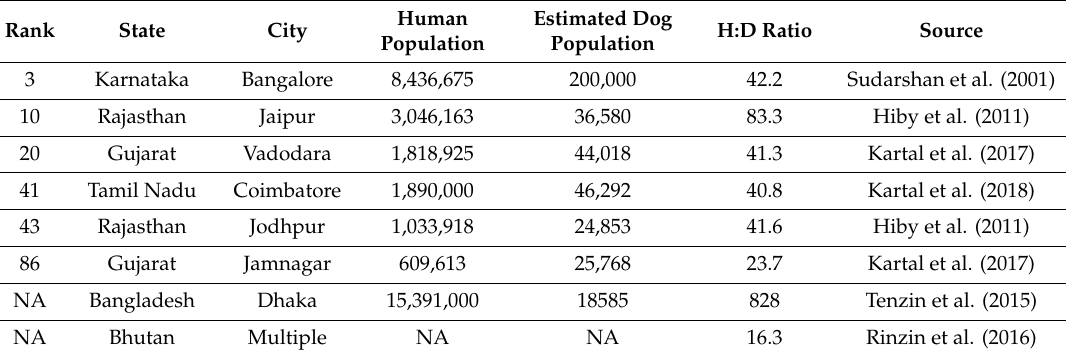
Table 1. Table of available literature for roaming dog population estimates of urban settings in India as well as a study from Bangladesh and Bhutan. Rank refers to ranked order of the city within all Indian cities according to the 2011 India human census. Human and estimated canine populations refer to those reported in the source article. Where human population is not given in the article, an estimate from the time of the study was